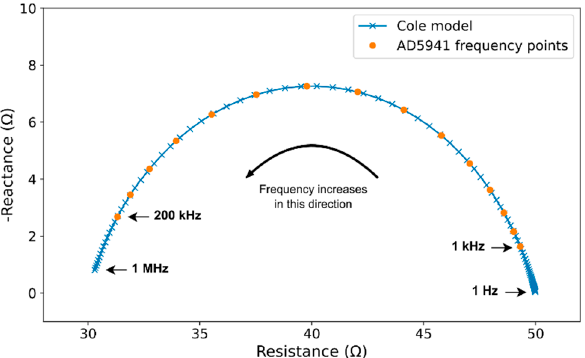
Figure 5. Wessel diagram of calf BI and the frequency points used by the BI sensor (AD5941). The Cole–Cole model values used are R ex = 50 Ω , R in = 75 Ω , and C m = 100 nF.